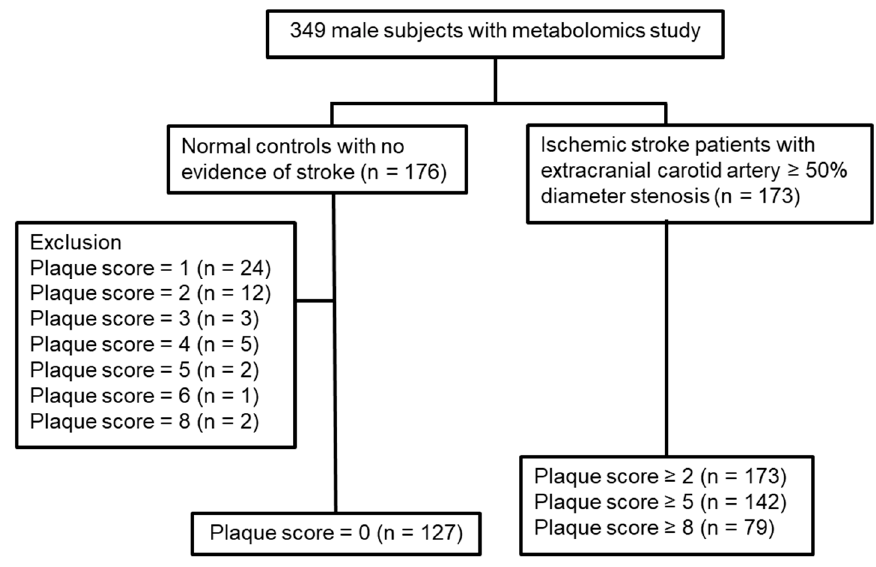
Figure 1. Flowchart of subject recruitment. Table 1. Comparison of baseline demographics between normal controls and the 3 subgroups of carotid artery